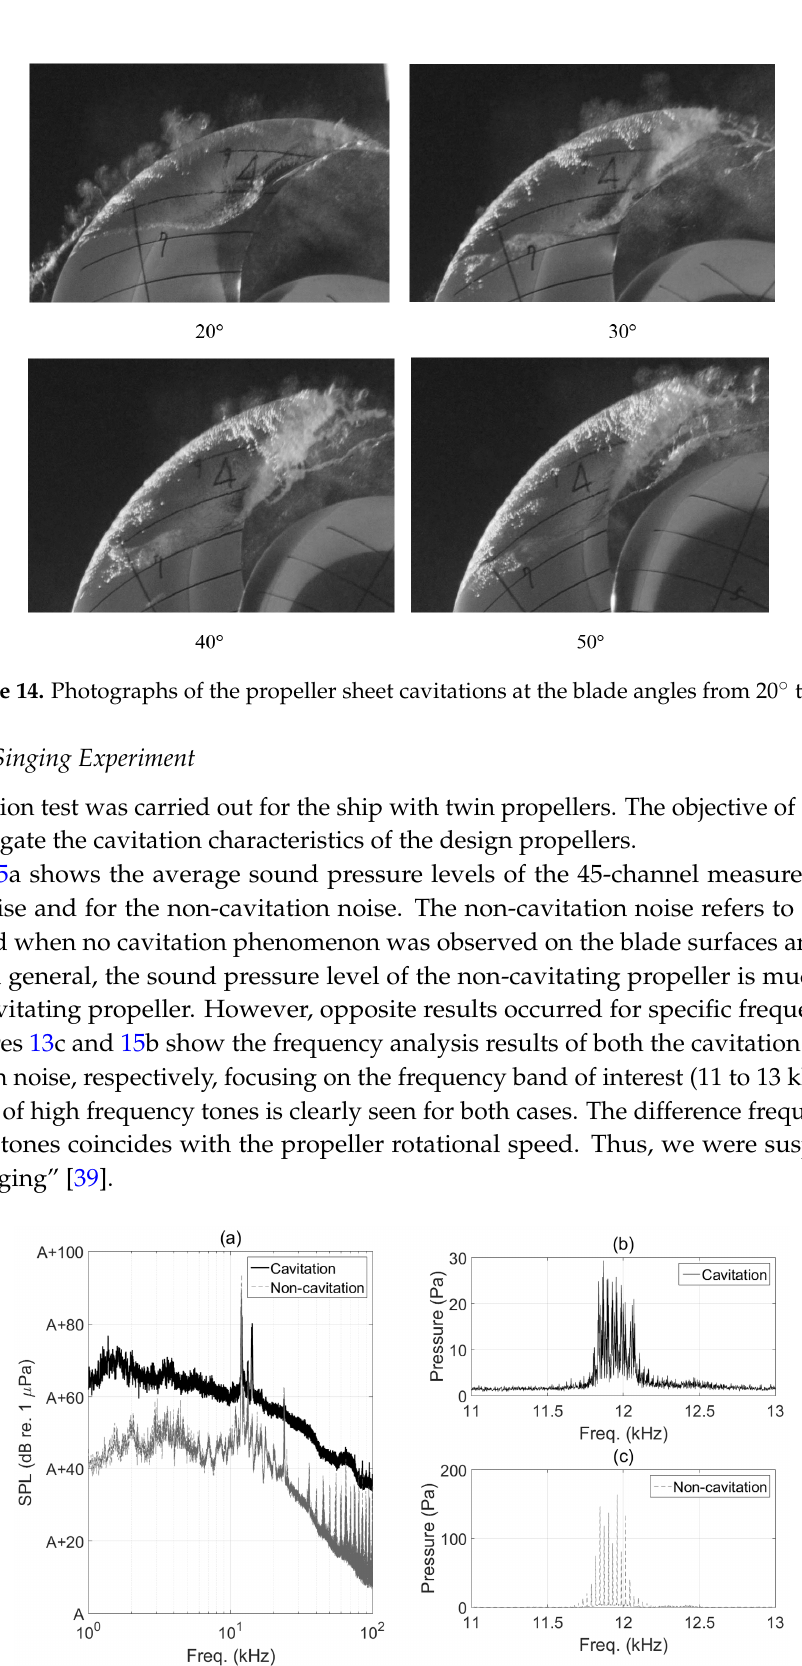
Figure 15. Average sound pressure levels of the 45-channel measurements for the cavitation noise and for the non-cavitation noise ( a ); tonal components for the cavitation noise ( b ); and the non-cavitation noise ( c